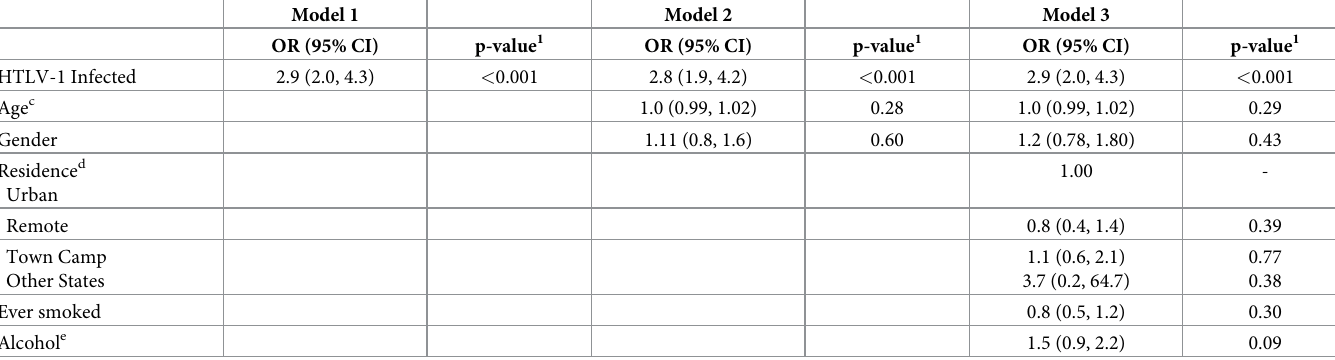
Table 3. Multivariable predictors of radiologically defined airway inflammation a among all subjects 1 (n = 840) b .